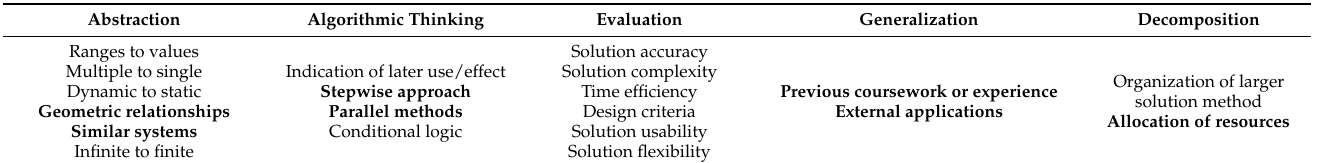
Table 3. Finalized codebook of CT practices for model-planning.